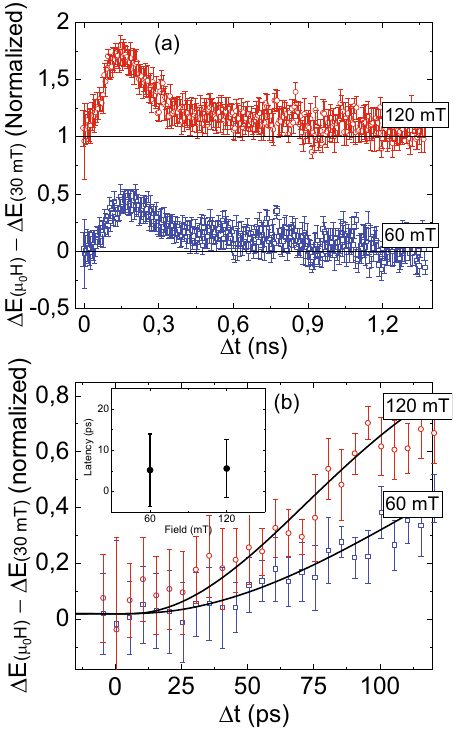
Fig. 7 The double-pump THz emission signals due to emerging H ¼ 0 ferromagnetism in antiferromagnetic FeRh/Au, Δ E( μ 0 H) – Δ E(30 mT) ( μ 0 H = 60, and 105 mT) at 300K. The data are binned for clarity. Panel a shows sub-nanosecond dynamics and panel b shows the picosecond dynamics with the fi t to Eq. (1). The inset shows the latency as a function of applied fi